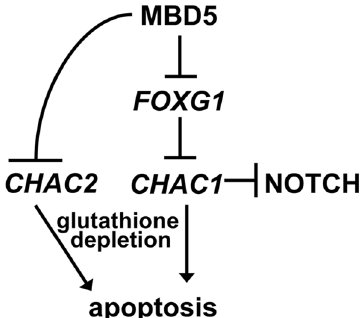
Figure 6. Schematic model of the possible role of MBD5 in regulation of glutathione, apoptosis, and Notch signaling